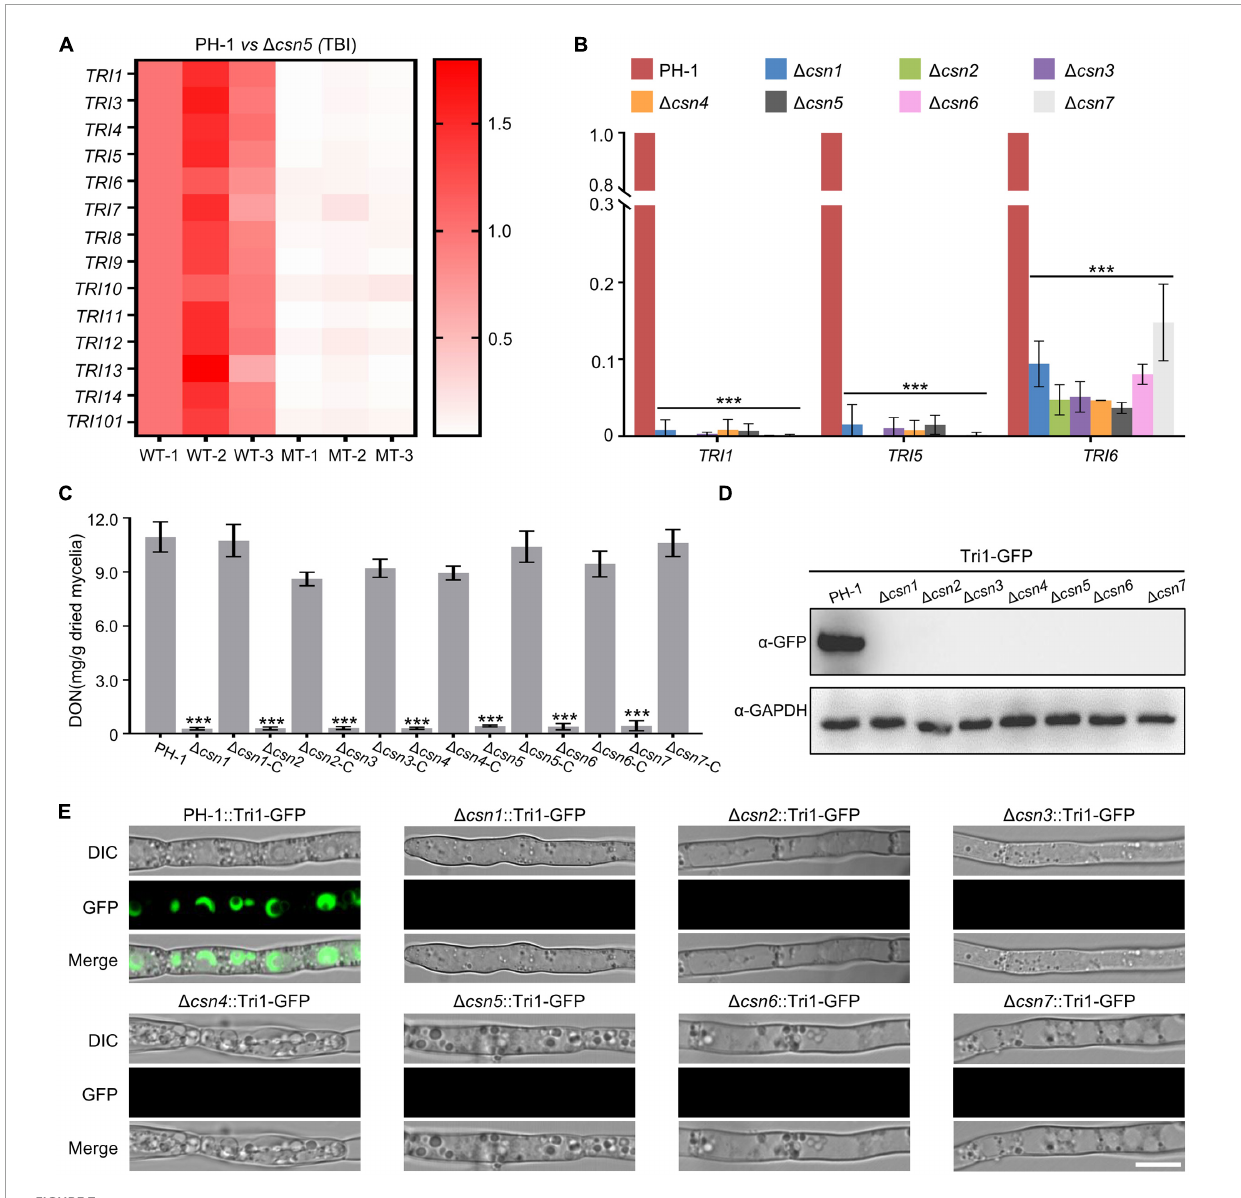
FIGURE7 Regulation of DON production by the Csn complex. (A) Heatmap comparing the relative transcriptional abundance of TRI genes in the wild-type strain or (cid:49) csn5 mutant in three independent replicates using transcriptomic analysis. WT, wild type. MT = (cid:49) csn5 mutant. The transcription levels of TRI genes in the replicate 1 of the wild-type strain were set to 1.0. (B) Bar charts showing the relative transcriptional abundance of TRI genes in the wild-type strain or indicated mutant strains using quantitative real-time PCR (qRT–PCR). (C) Bar charts showing DON production in 7-day-old TBI cultures of the indicated strains. (D) Western blot analysis of Tri1 protein levels in tested strains expressing Tri1-GFP with the anti-GFP antibody. GAPDH was used as an internal control. (E) Fluorescence signals of Tri1-GFP were detected in the tested strains after growth in liquid TBI medium for 48 h. Bar = 10 µ m. Error bars indicate the standard deviation from three independent experiments. Statistical analysis was performed via Student’s t -test. A triple asterisk indicates statistical significance with p <